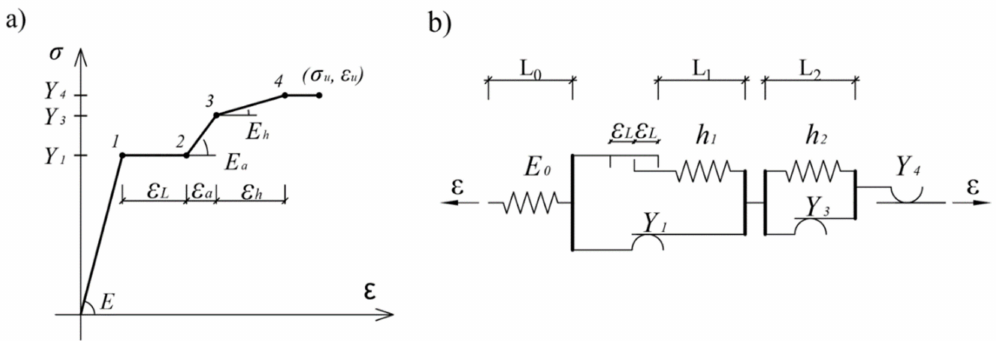
Figure 3. ( a ) Quintuple linear working diagram and ( b ) mechanical